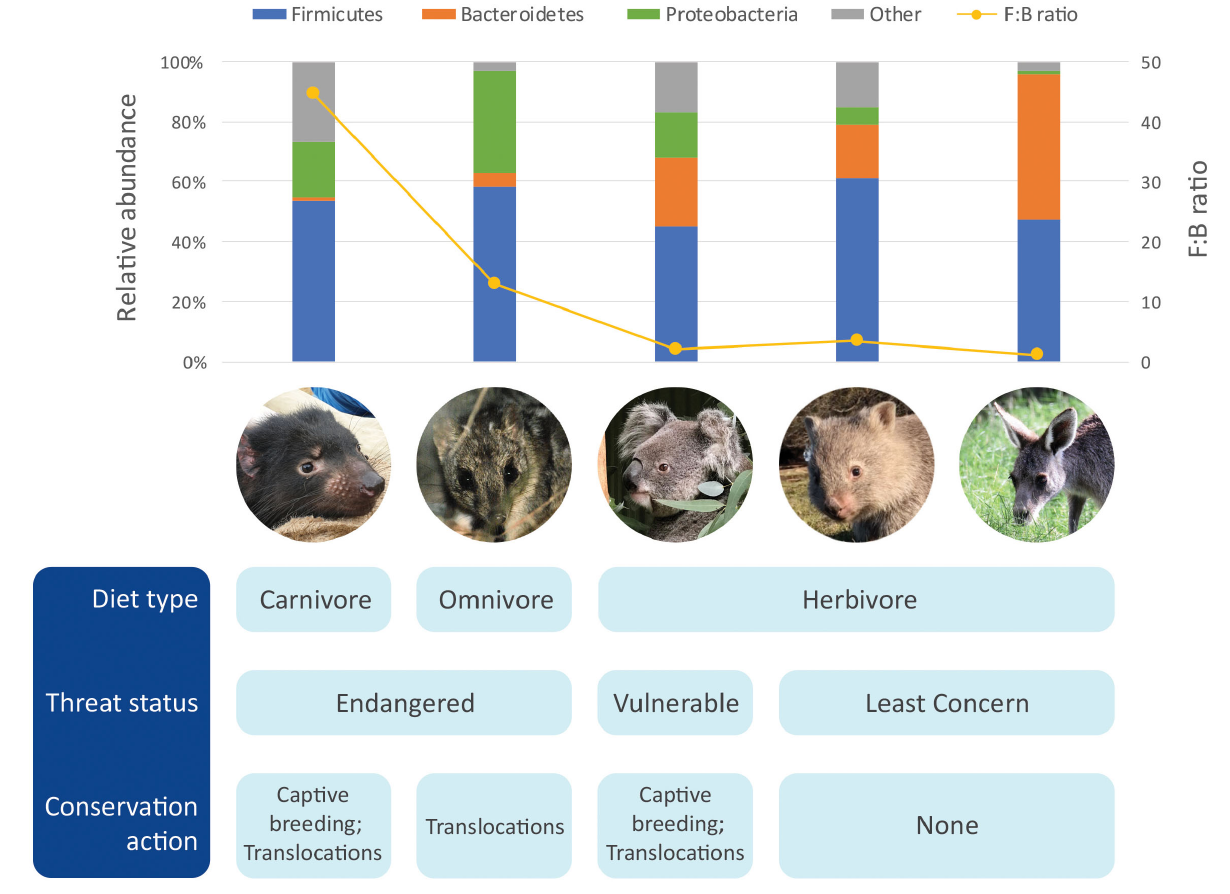
FIGURE 1 | Comparison of gut microbiome of five marsupials [data from Barker et al. (2013), Gulino et al. (2013), Cheng et al. (2015), Shiffman et al. (2017), Burke et al.